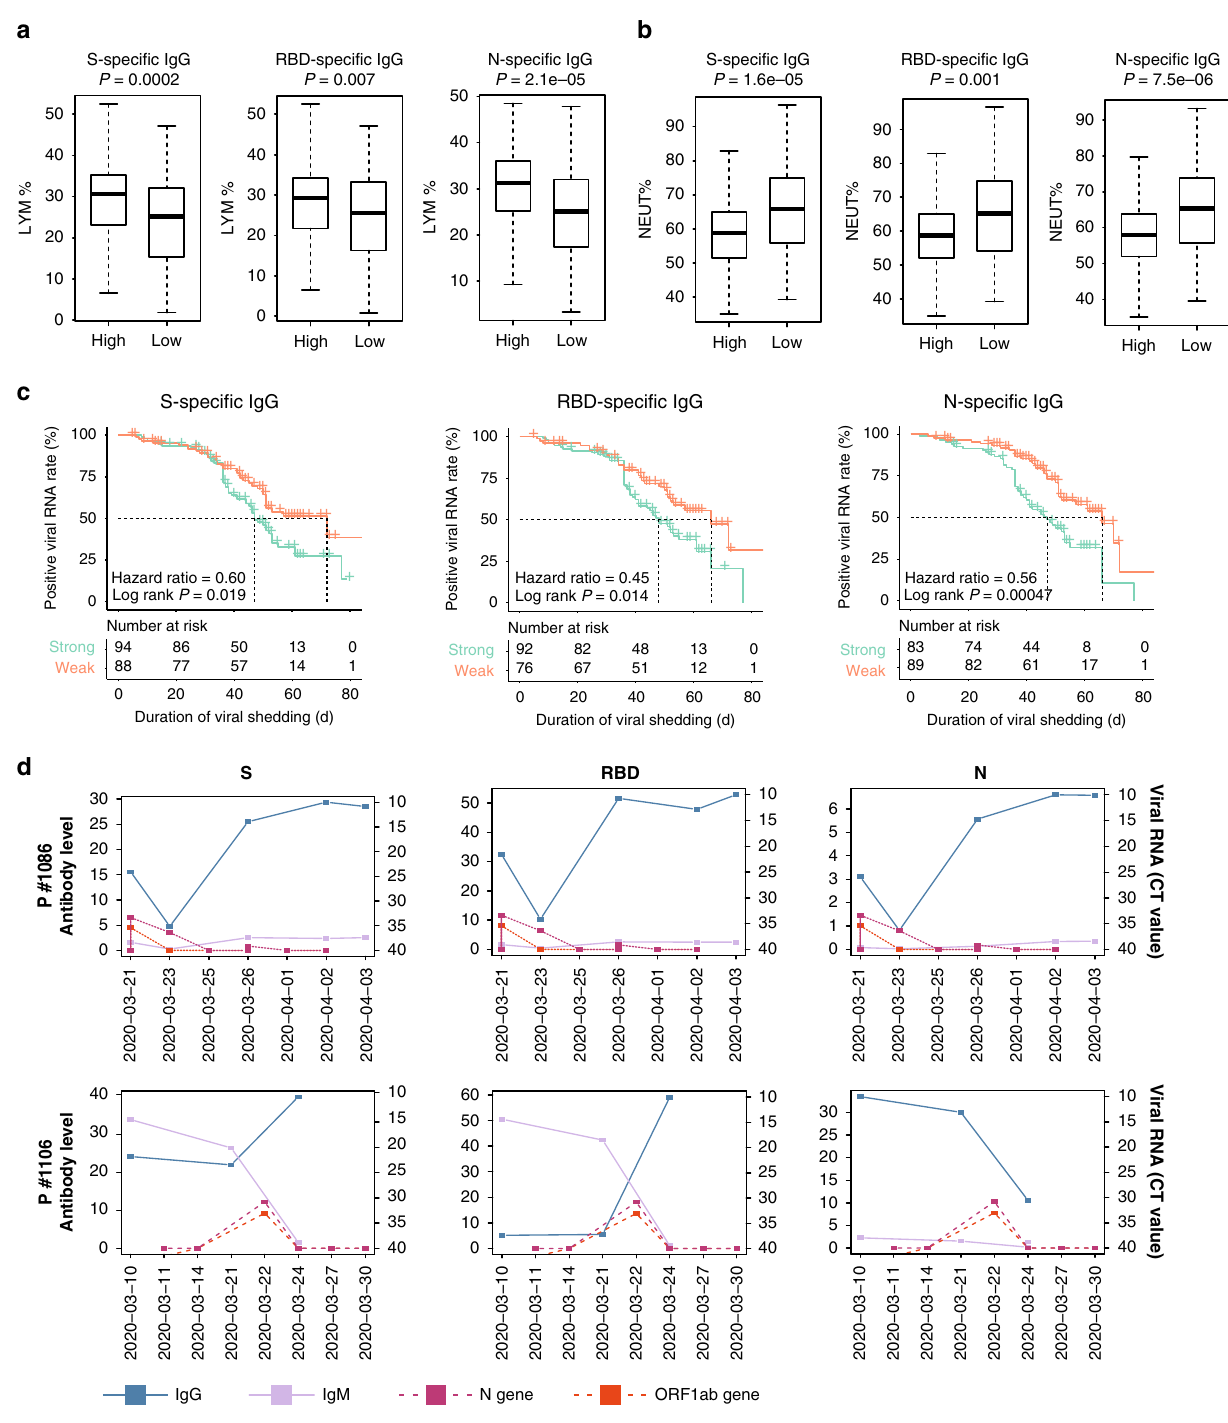
Fig. 2 Relationship between the levels of IgG and the clinical outcome of COVID-19 patients. The percentage of lymphocytes ( a ) and neutrophils ( b ) in severe/critical COVID-19 patients with different N-, RBD-, and S-speci fi c IgG levels. Antibody levels and lymphocyte/neutrophil percentages were measured on the same day, with 112 sets of measurements for both the low- and high-antibody groups. Horizontal lines in the boxplots represent the median, the lower, and the upper hinges correspond to the fi rst and third quartiles, and the whiskers extend from the hinge up to 1.5 times the interquartile range from the hinge. P values were calculated with a two-sided Wilcoxon rank-sum test. c Kaplan – Meier analysis of the viral shedding time in patients with strong and weak antibody responses. The X axis represents the duration of viral shedding (days). The Y axis represents the positive rate of viral RNA. P values were calculated with the log-rank test. d The dynamic changes in antibody levels and virus RNA load in Patients #1086 and #1106. The X axis represents the detection date. The Y axis on the left represents the antibody level, and the Y axis on the right represents the cycle threshold (CT) value of PCR for the detection of viral RNA load. A CT value <40 was de fi ned as SARS-CoV-2 viral positive. Blue dots represent IgG levels, purple dots represent IgM levels. The ORF1ab and N genes of SARS-CoV-2 were represented as pink and orange dots, respectively.